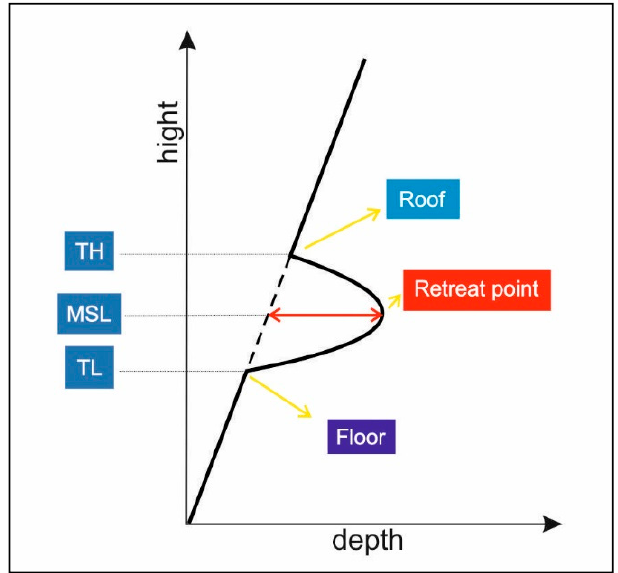
Figure 4. Sketch of initial tidal notch profile with characteristic points. TH—high tide level, TL—low tide level, MSL—mean sea level.